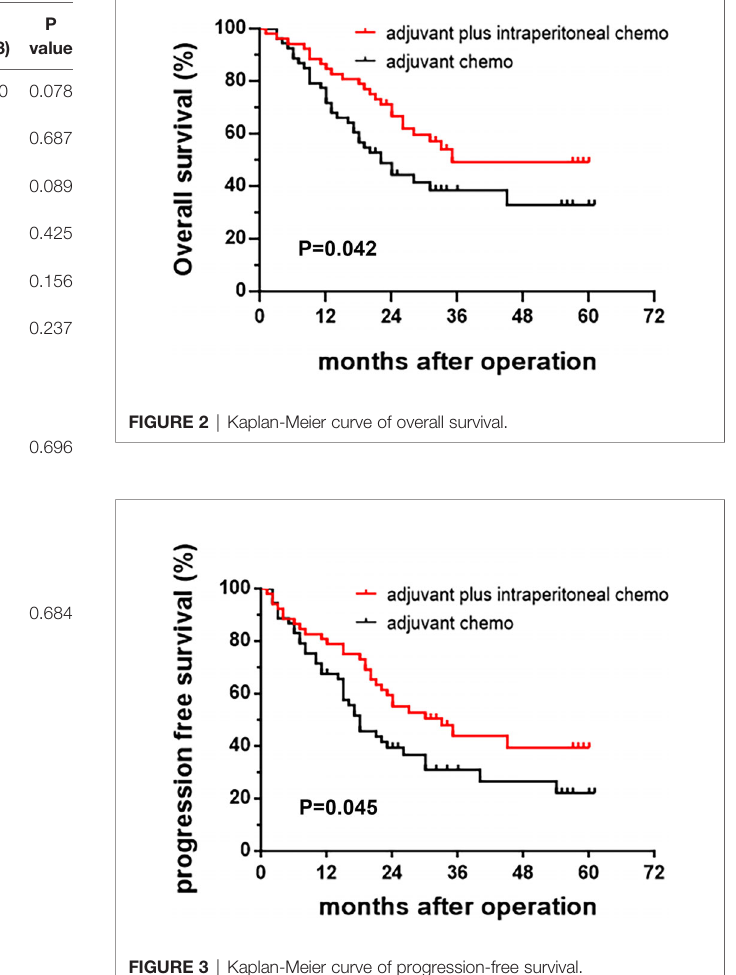
FIGURE 3 | Kaplan-Meier curve of progression-free survival.